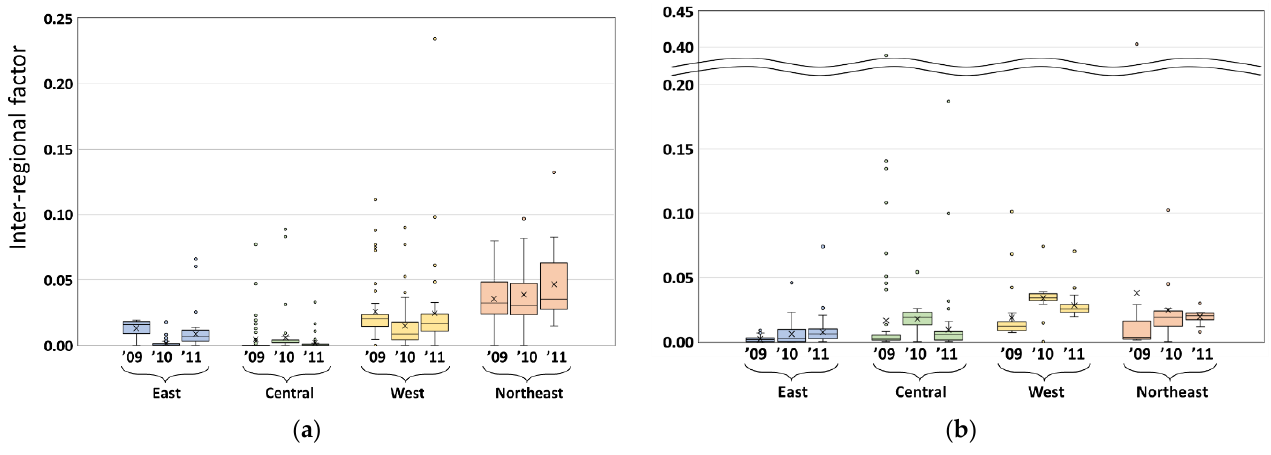
Figure 4. Change in average utilization ratio for SM and LARGE groups.